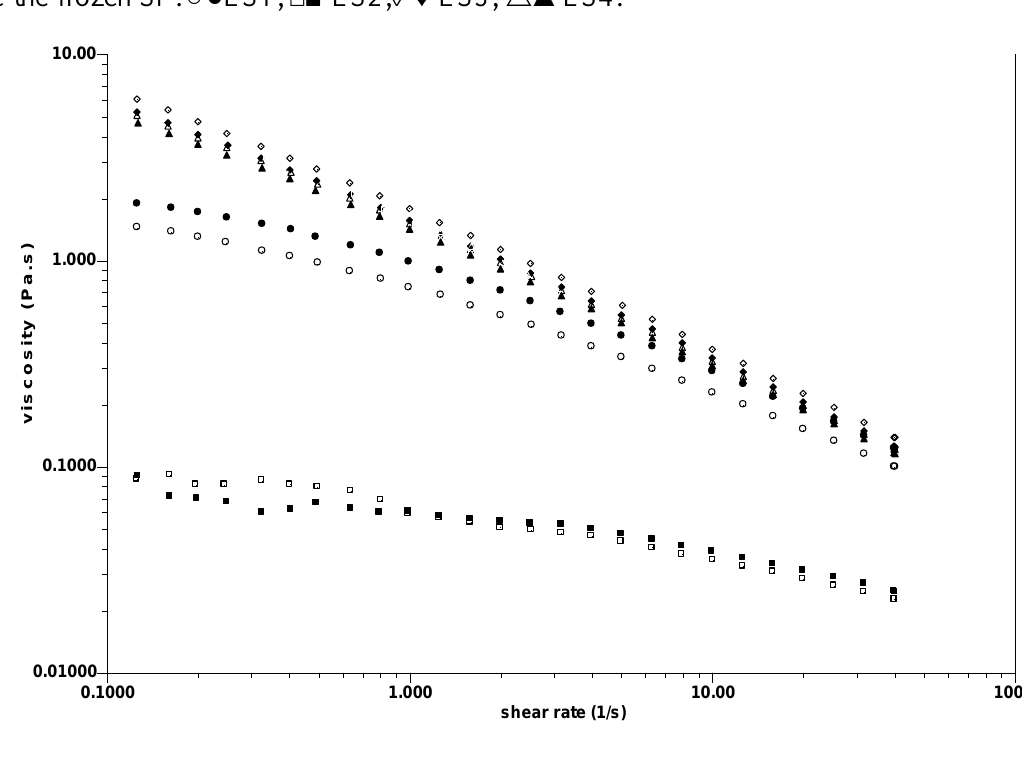
Figure 4. Influence of freezing at –21 °C on rheological behaviour of 4 different SF measured at 25 °C. Open signs correspond to the initial SF; the corresponding filled signs are the frozen SF. ○● LS1; □■ LS2; ◊ ♦ LS3;  ▲